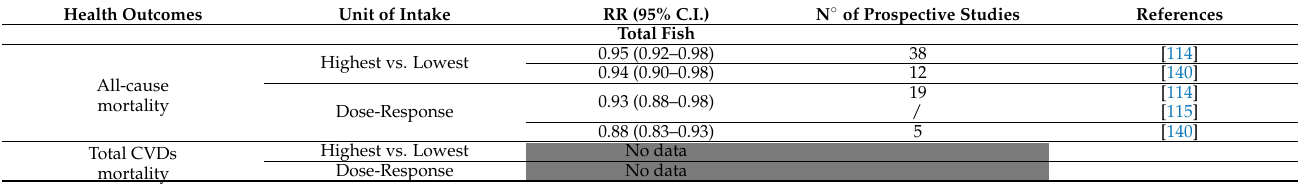
Table 4. Association between total fish, oily fish, and lean fish intake and some incidences of major chronic diseases/mortality of major disease groups (RR, 95% C.I.). The dose-response meta-analysis always refers to an additional serving of a food per day relative to the average intake of that food observed in a cohort study (100 g for total fish, oily fish, and lean fish). Health Outcomes Unit of Intake RR (95% C.I.) N ◦ of Prospective